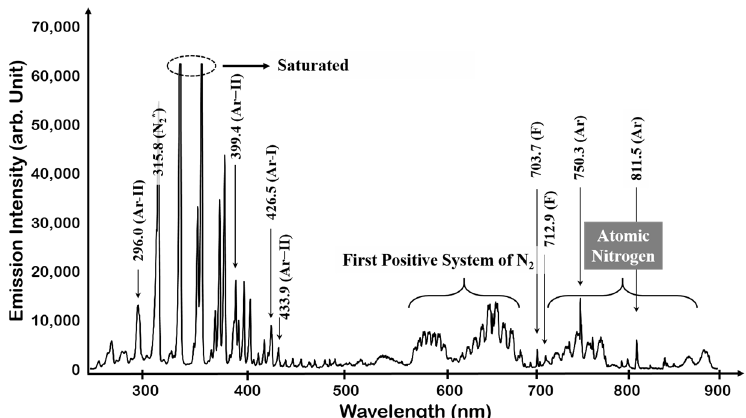
Figure 6. OES spectrum of NF 3 plasma.